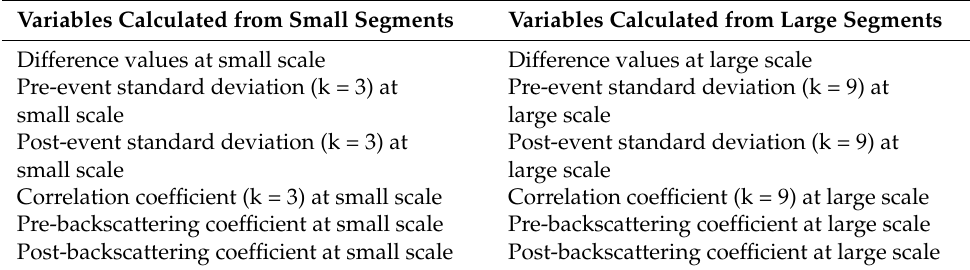
Pre-event standard deviation (k = 9) at large scale Post-event standard deviation (k = 9) at large scale